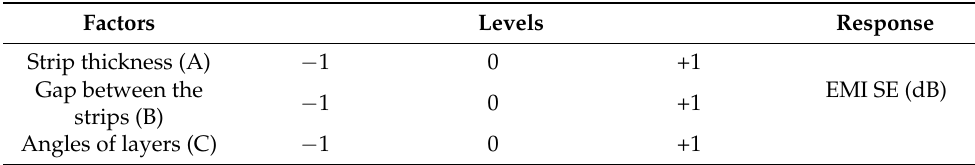
Table 3. Factors and its levels used for